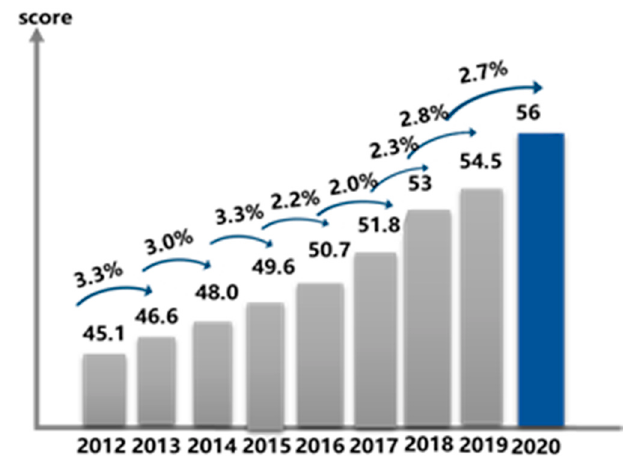
Figure 14. Historical data of sector’ digital transformation in China.